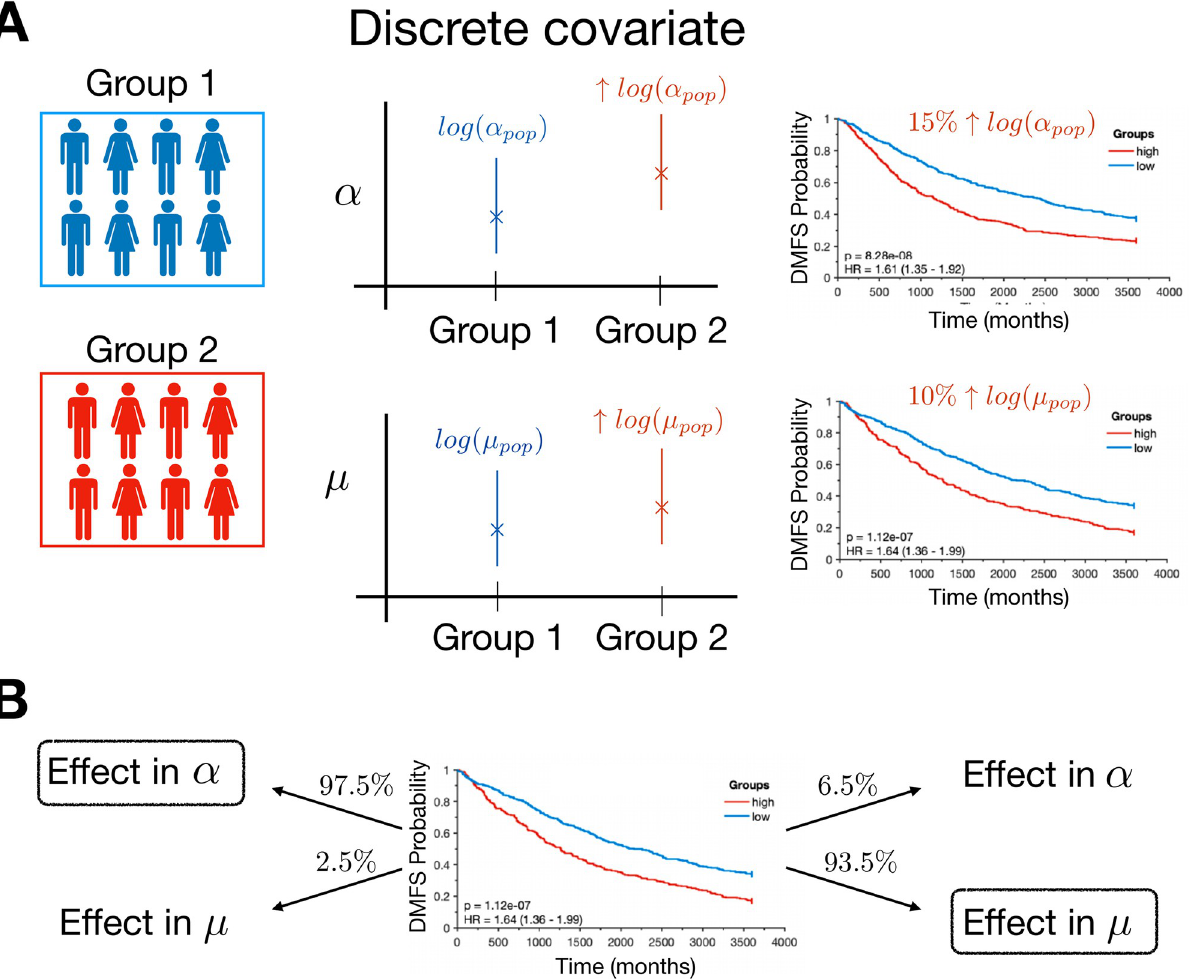
Fig 3. Effect of a categorical covariate. A) Scheme of model simulation with an effect of a categorical covariate in α or μ . The individual values α i and μ i are sampled from different distributions depending on the group. In the right panel, differences in the survival curves are displayed for the two groups. B) Inference of the right effect from the data.